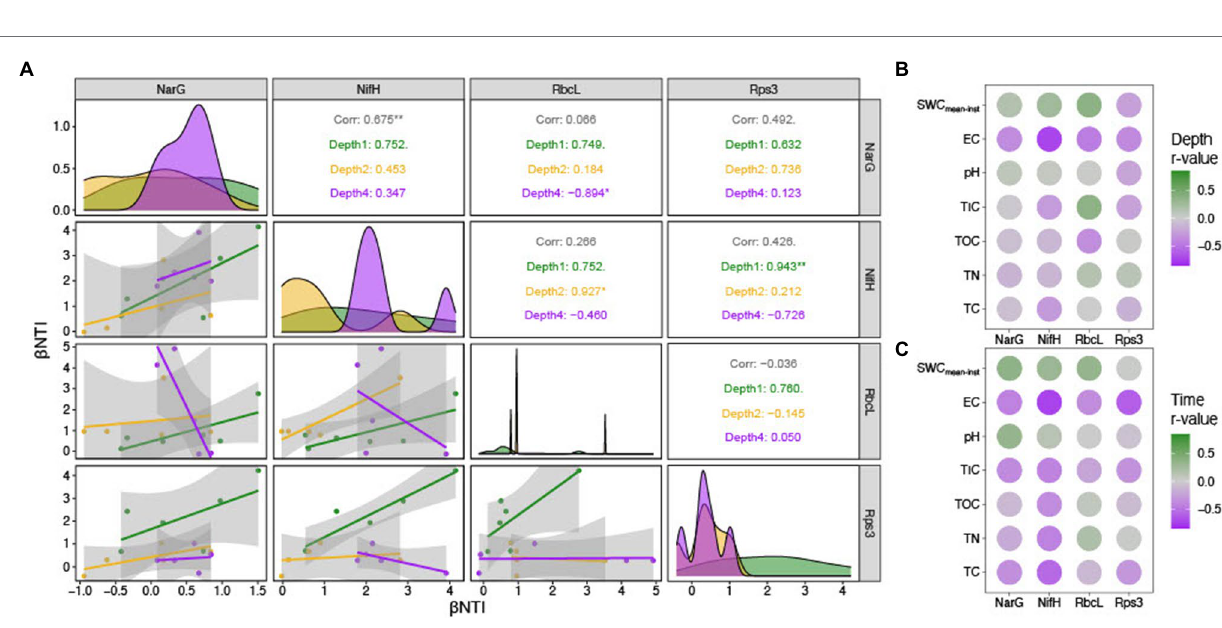
FIGURE 7 | Stochastic processes governed functional community assembly, with related patterns between marker genes and with environmental variables. β NTI comparisons to investigate sub-population assembly dynamics. (A) Pairwise correlation plot between the average β NTI values for four sub-populations defined by nitrate reductase subunit G (narG), nitrogenase subunit H (nifH), RuBisCO large subunit (rbcL), and ribosomal protein subunit 3 (rps3) sequences. (B) Depth- controlled (i.e., only within-depth β NTI values were analyzed) correlation matrix with colors indicating the correlation coefficient. (C) Time-controlled (i.e., only β NTI values from the same date were analyzed) correlation matrix with colors indicating the correlation